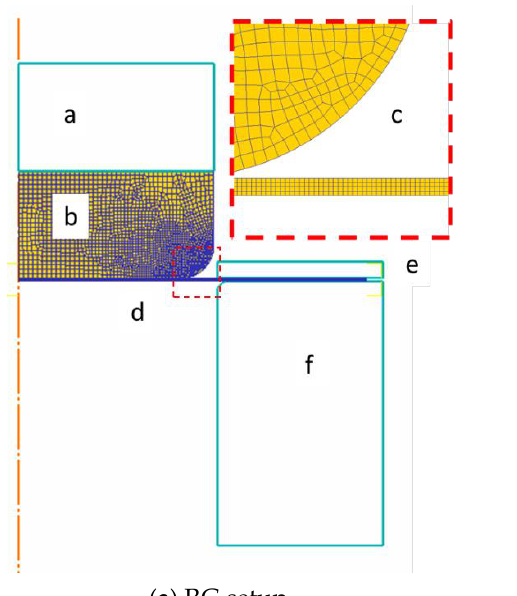
Comparison of cup LP profiles (experimental, simulation, CAD);